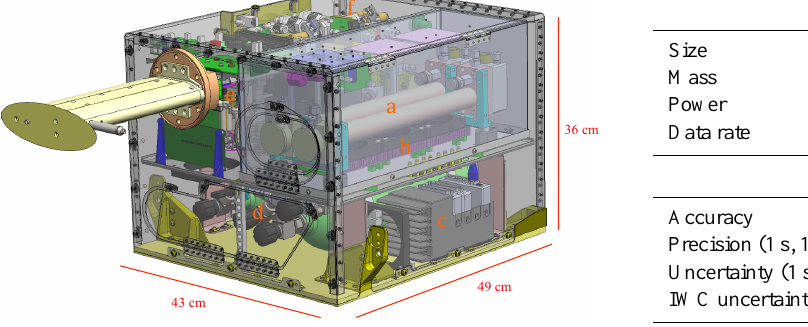
Table 1. NOAA Water instrument